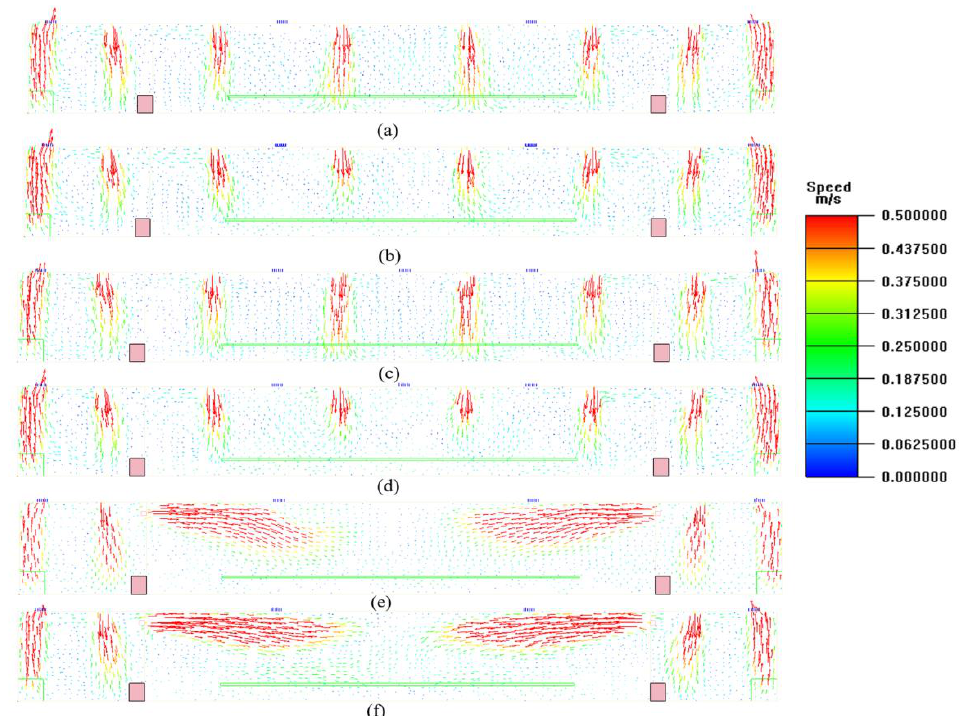
Figure 9. Vector diagram of velocity distribution at Z = 18 m: Scheme 1 in summer ( a ), Scheme 1 in winter ( b ), Scheme 2 in summer ( c ), Scheme 2 in winter ( d ), Scheme 3 in summer ( e ), and Scheme 3 in winter ( f ).